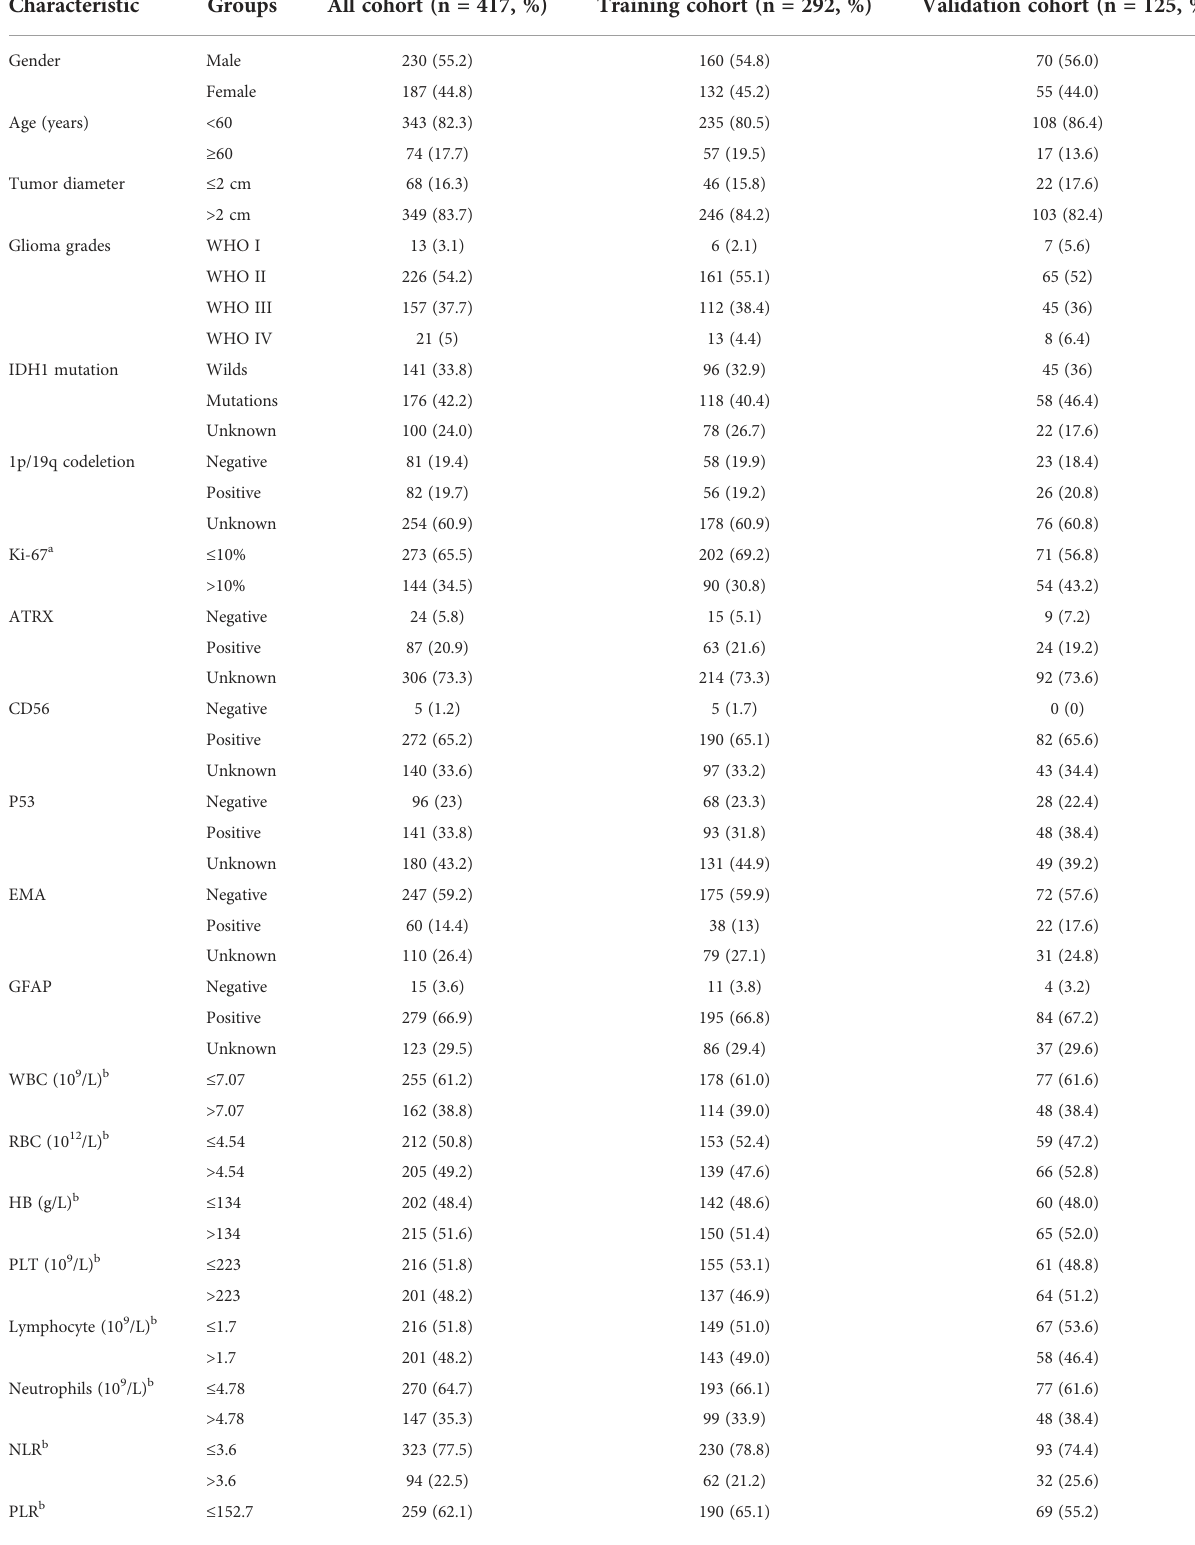
TABLE 1 Demographic and clinical – pathological characteristics of the training cohort and validation